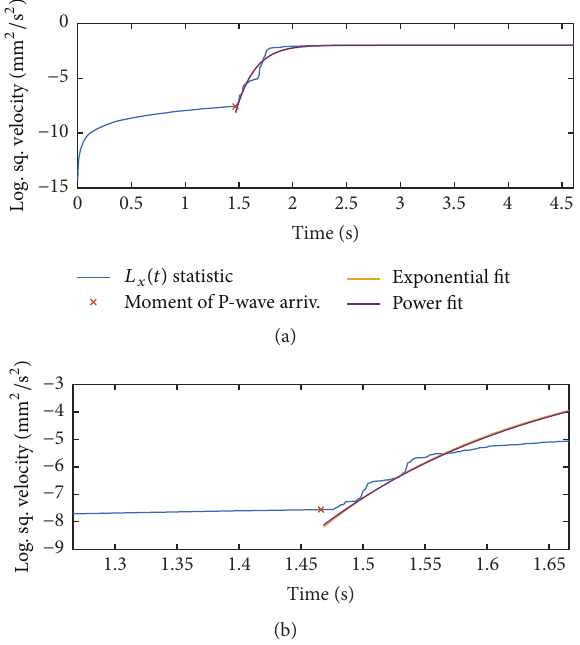
Figure 3: 𝐿 𝑥 󸀠 (𝑡) statistic applied to exemplary seismic signal presentedinFigure1 ( a ) anditszoom(b).Fitparameter 𝑅 2 = 0.9557 and 0.9591 for exponential and power function fitting,